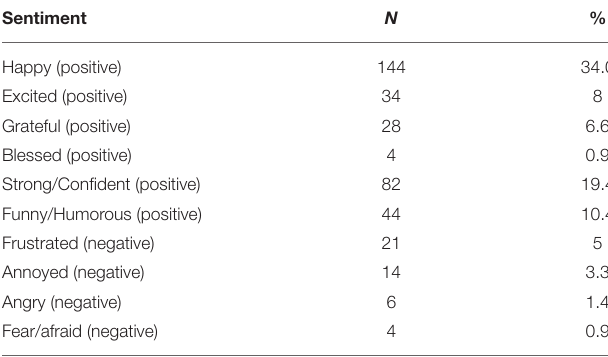
TABLE 3 | #t1dlookslikeme posts coded for sentiment ( N = 423).